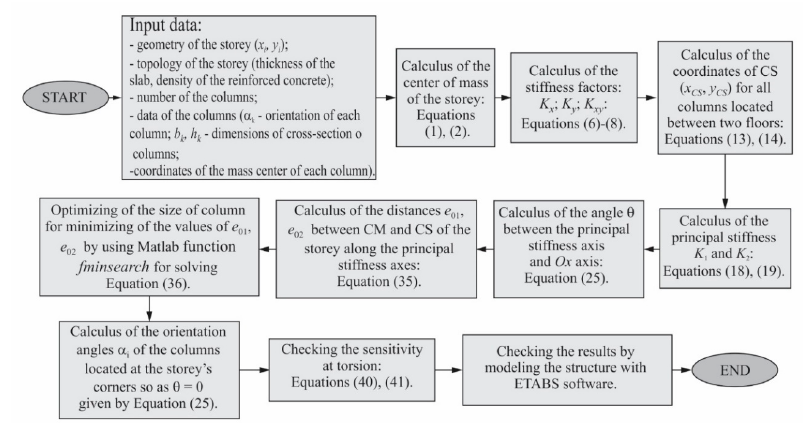
Figure 3. Flow chart of program (by using Matlab software) for calculus in order to minimize the distance between centre of mass (CM) and centre of stiffness (CS) and to cancel the angle θ (orientation of the principal rigidity axes).